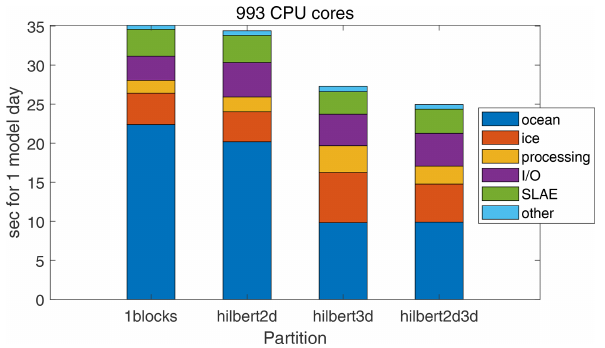
Figure 9. Absolute contribution of different code sections to run- time on 993 CPU